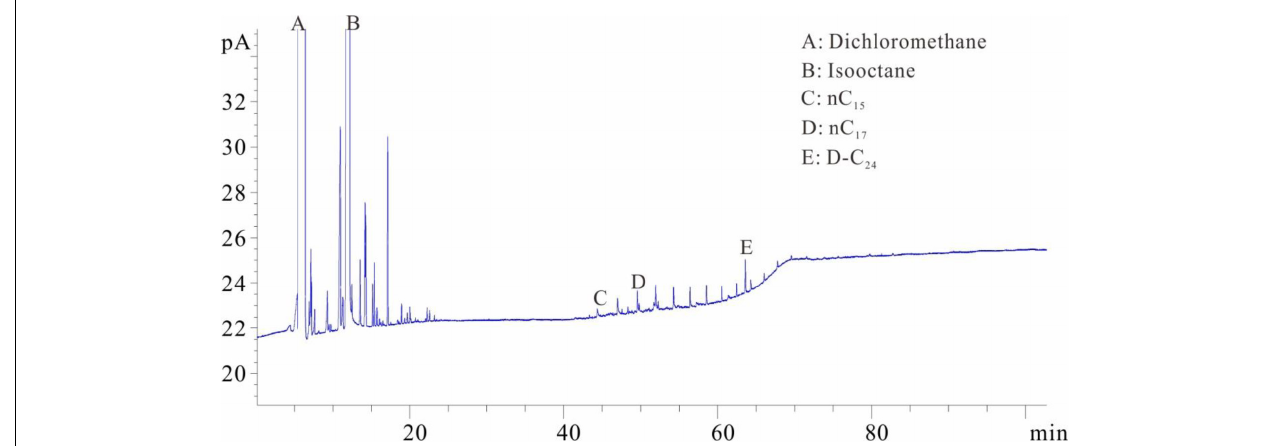
Frontiers in Earth Science |